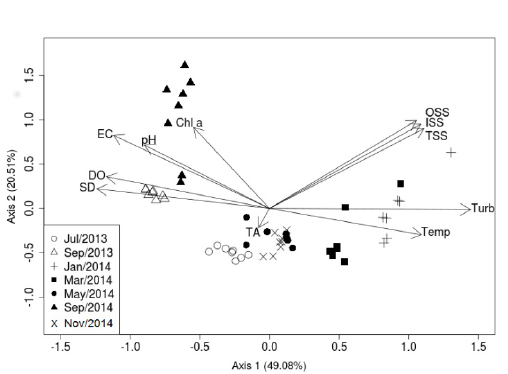
Figure 3. Biplot of principal component analysis (PCA) performed with the physical and chemical variables (EC: electrical conductivity; DO: dissolved oxygen; Turb: Turbidity; Temp: water